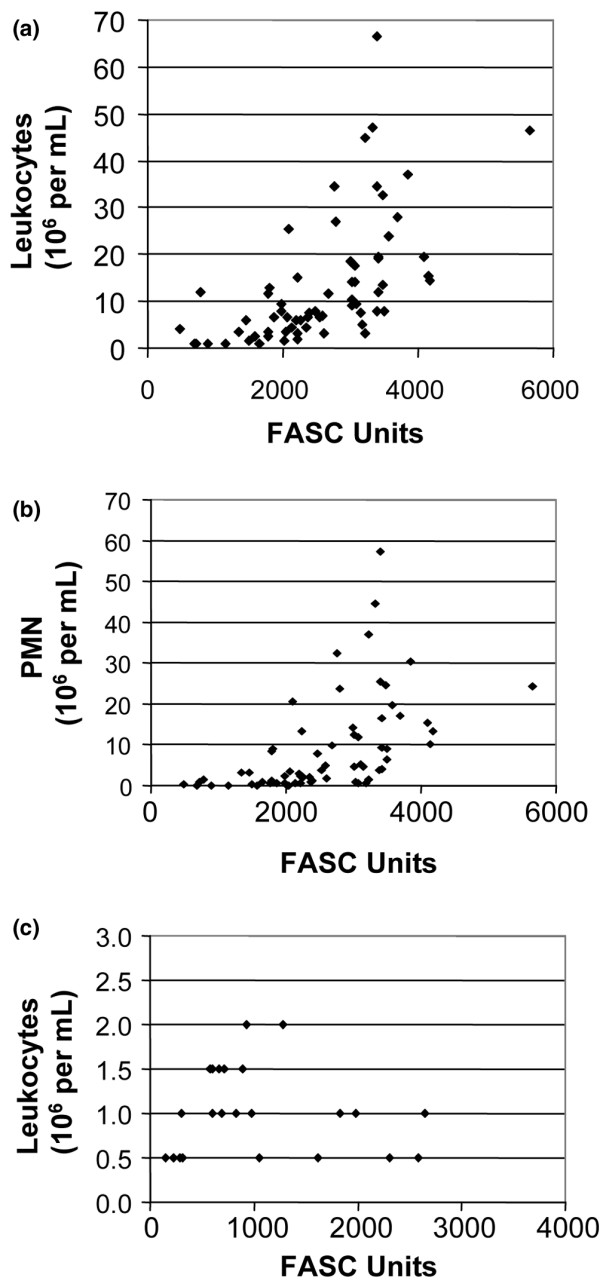
Correlation between the level of proteolytic activity found and the number of infiltrating leukocytes. Positive correlation between the net proteolytic activity (NPA) and the number of (a) infiltrating leukocytes (rs = 0.710, P < 0.001) or (b) polymorphonuclear cells (PMN) (rs = 0.696, P < 0.001) in synovial fluids of patients with inflammatory arthritis. (c) No such correlation between the NPA and the number of infiltrating leukocytes was observed in osteoarthritis (OA) patients. Each point represents one sample. The correlation was calculated using Spearman's rank correlation coefficient for each test. FASC, fluorescent-activated substrate conversion.